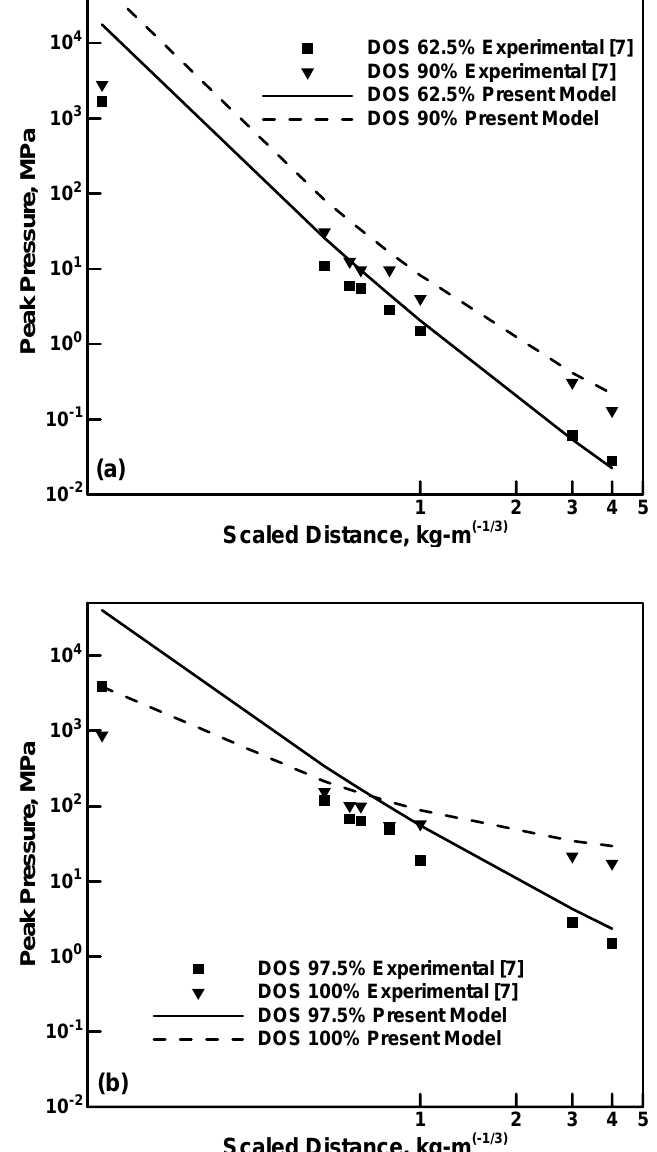
Fig. 7. Variation of peak pressure with the scaled distance from the charge center and the degree of saturation. Explosive weight and type: 8 kg TNT; Sand type: Sandy loam. reported in Ref. [12]. The computational analysis carried out in this section follows closely the computational analysis performed in Ref. [10] (except that the new materials model is used for sand) and, hence, only a brief description of the computational model analyzed is given